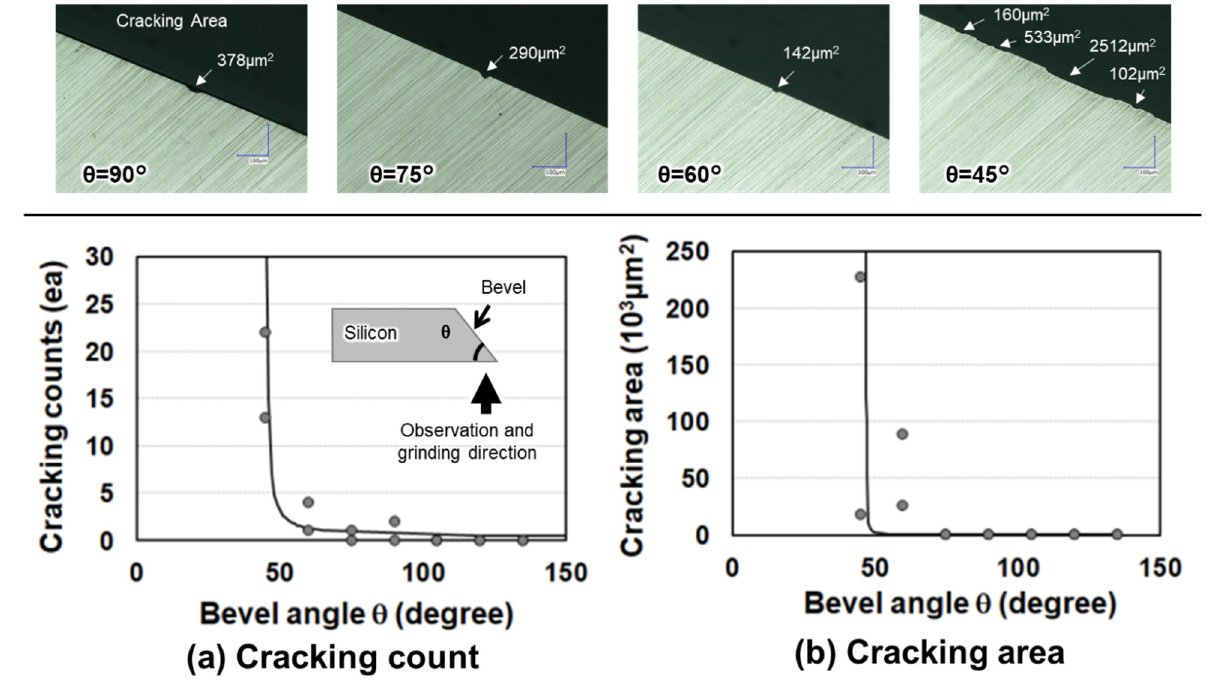
Figure 9. Top-view pictures of the wafer edge after grinding for the bevel angle-controlled sample. ( a ) and ( b ) show the number of cracks and the cracking area as a function of edge position and bevel angle, respectively. Cracking tends to increase with decreasing bevel angle, significantly below 60 degrees. Since cracking occurs randomly along the wafer edge, it might be caused by the grinding step and conditions of the grindstone.